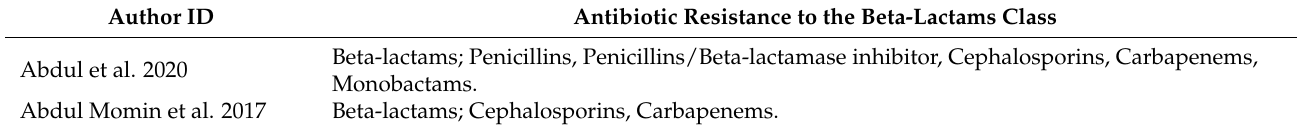
Table A2. The list of antibiotic classes under Beta-lactams with resistance to MDR K. pneumoniae in 47